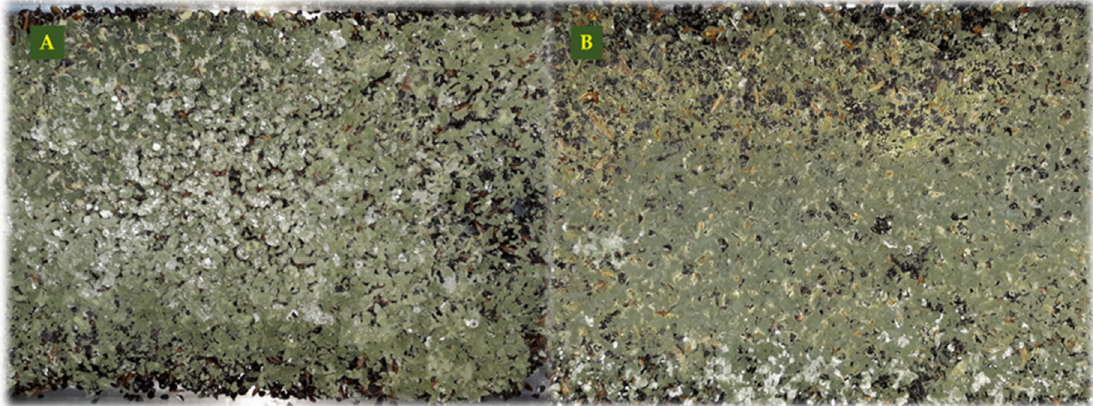
Figure 1. Mass production of ( A ) Trichoderma aggressivum f . europaeum and ( B ) Trichoderma saturnisporum on 70 + 30% for buckwheat husk and oats.